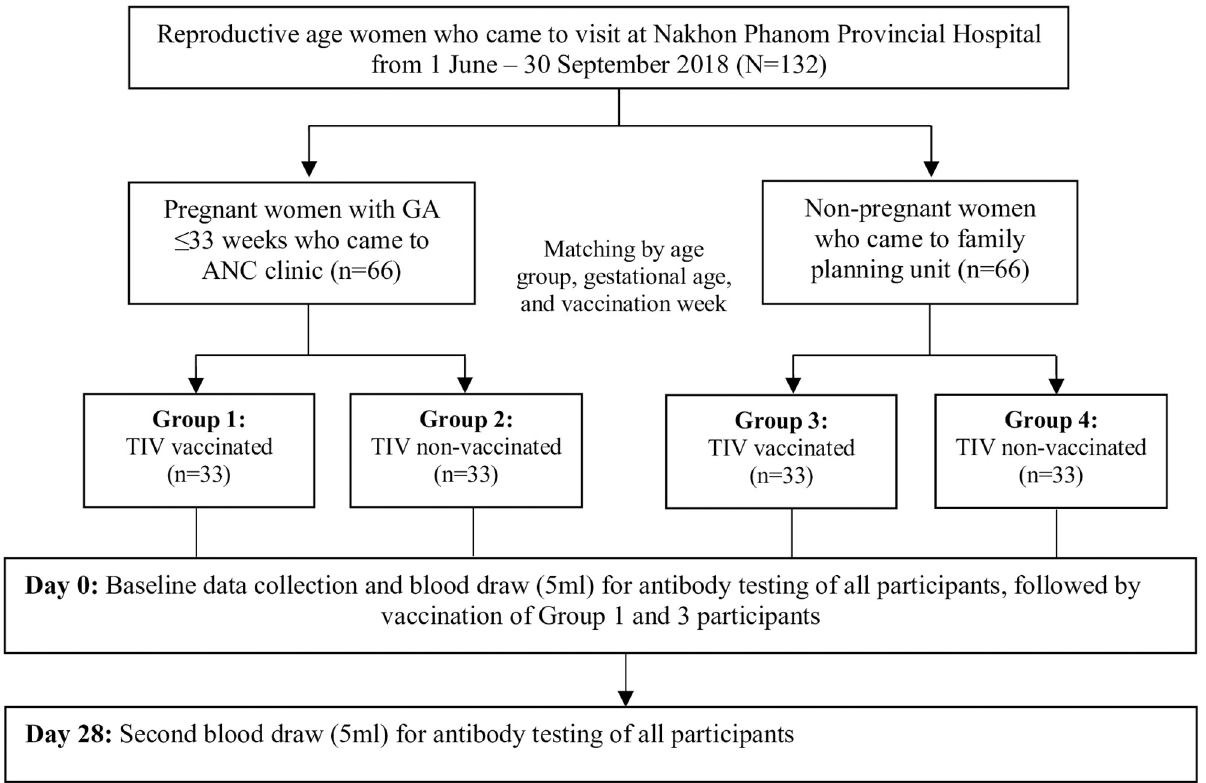
Fig 1. Study flow